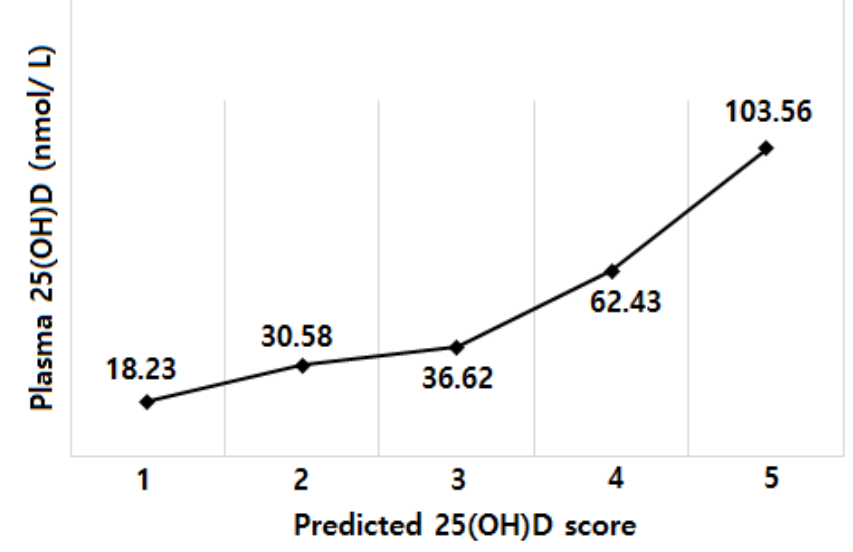
Figure 2. Mean actual 25(OH)D concentrations by quintile of predicted 25(OH)D score in the validation sample. Table 3. Odds ratio (OR) and 95% confidence interval (CI) for the association between selected factors and plasma 25(OH)D status (<50 nmol/L) among the breast cancer survivors.